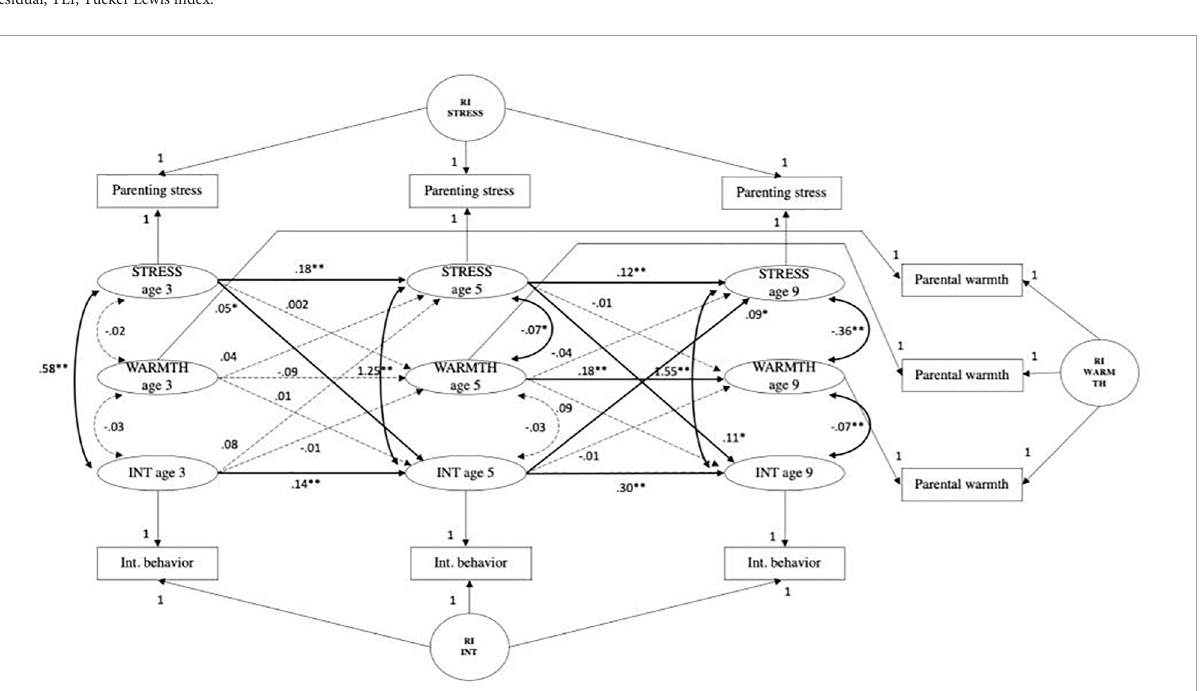
FIGURE2 Random intercepts cross-lagged panel model showing relations among parenting stress (STRESS), parental warmth (WARMTH) and child internalizing behaviors (INT) across three waves. Age 3, wave 2; age 5, wave 3; age 9, wave 5; R, residual variance; RI INT, random intercept child internalizing behavior; RI STRESS, random intercept parenting stress; RI WARMTH, random intercept parental warmth. Standardized estimates reported. Gray dashed paths indicated non-significant estimates. ∗ p < 0.01, ∗∗ p <